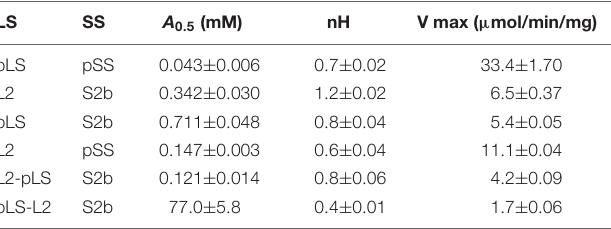
TABLE 1 | Sensitivity of the AGPase variants to 3-PGA